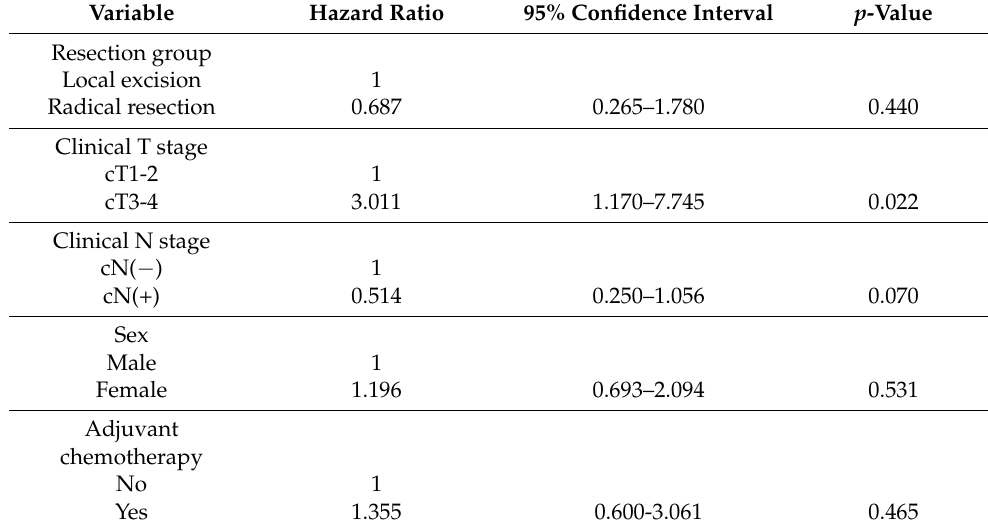
Table 3. Factors associated with recurrence-free survival in ypT0-1 rectal cancer treated with preoper- ative chemoradiotherapy.